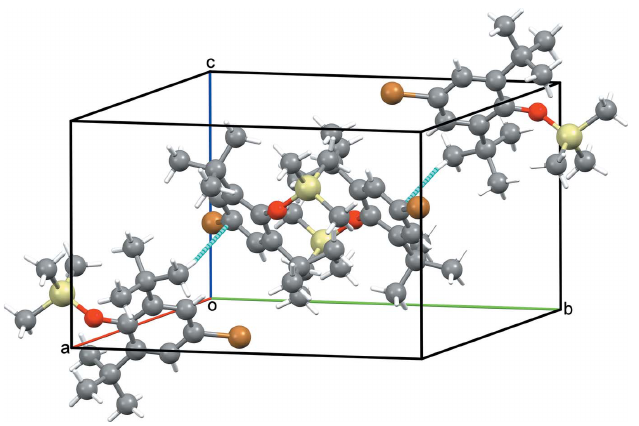
Figure 2 Unit-cell packing diagram for (I) viewed bisecting (cid:2) with H atoms shown with arbitrary radii and intermolecular contacts less than (cid:2) rvdW as dashed blue